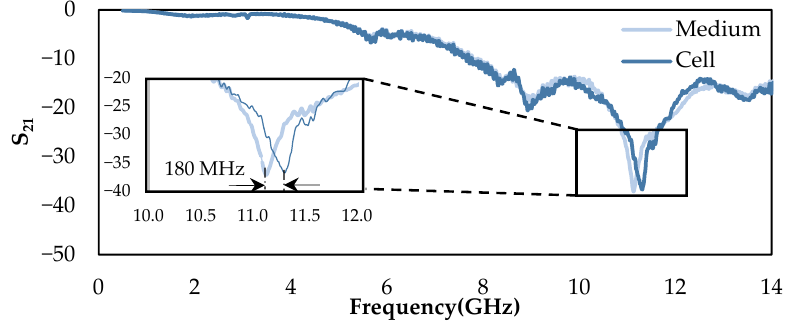
Figure 10. Measured frequency response of the insertion loss (S 21 ) for the medium compared to the